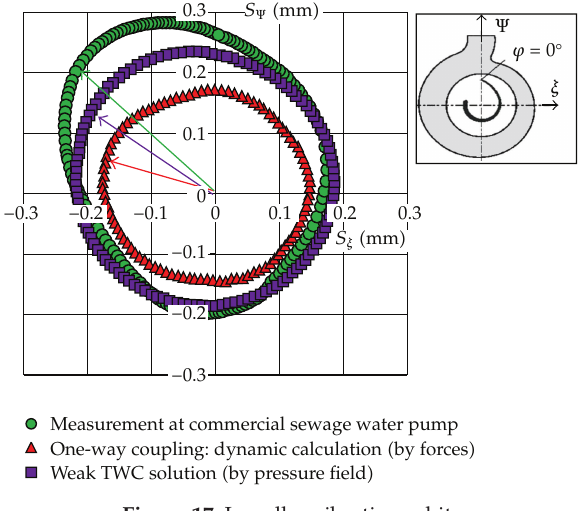
Figure 17: Impeller vibration orbit.